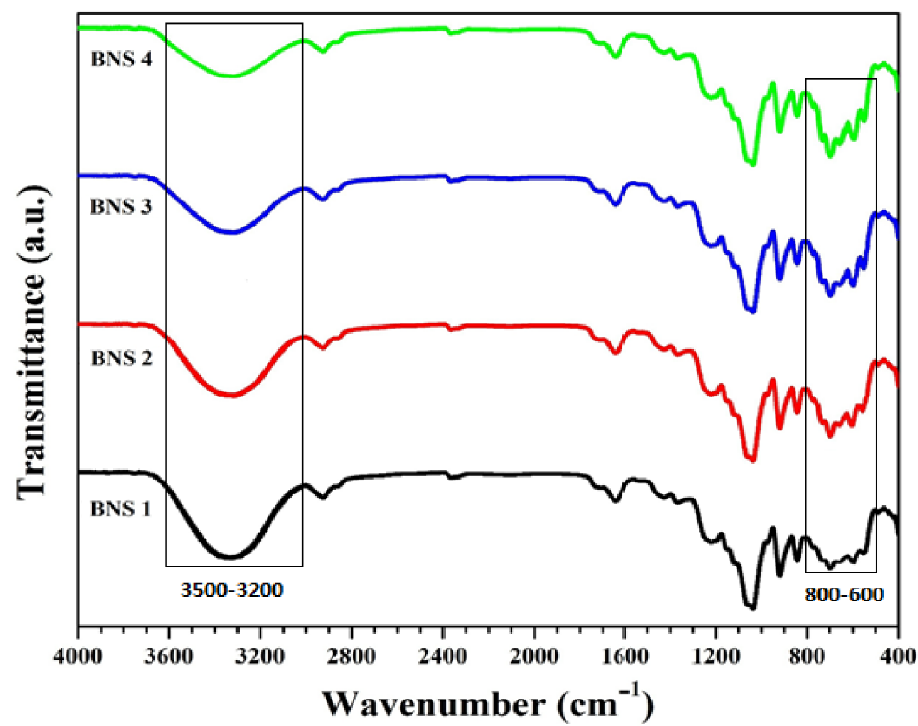
Figure 2. Fourier transform infrared spectroscopy (FTIR) spectral profiles show various functional groups along with their different modes of vibrations available in the BNS.